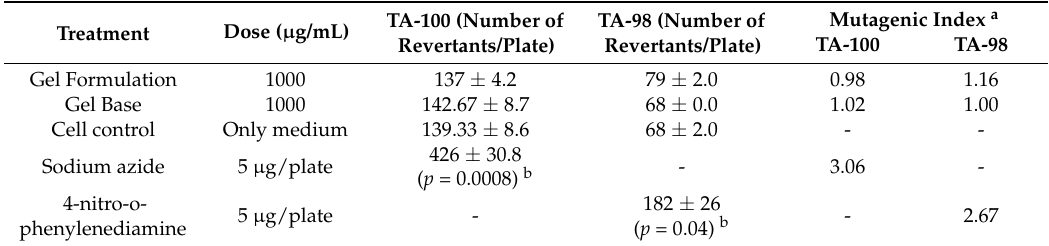
Table 4. Mutagenesis in S. typhimurium strains TA100 and TA98 treated with gel